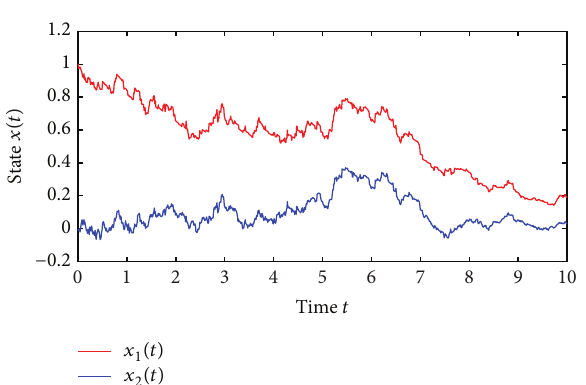
Figure 2: State trajectory of the closed-loop